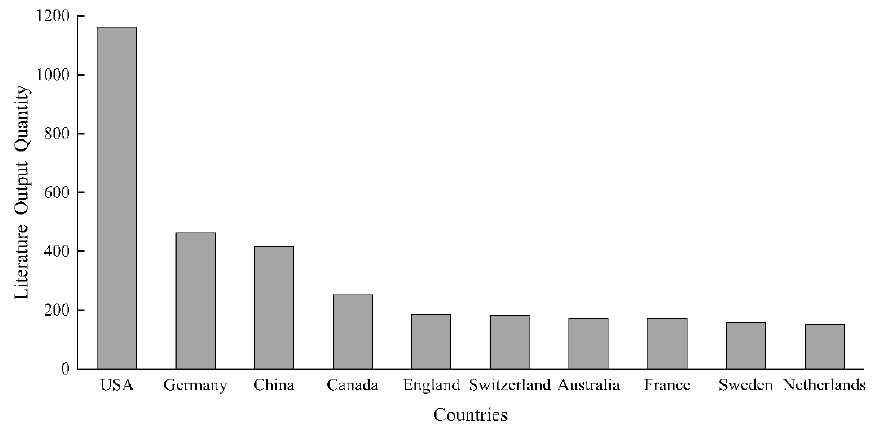
Figure 5. Quantity of literatures on preferential flow published by different countries in the past 30 years.